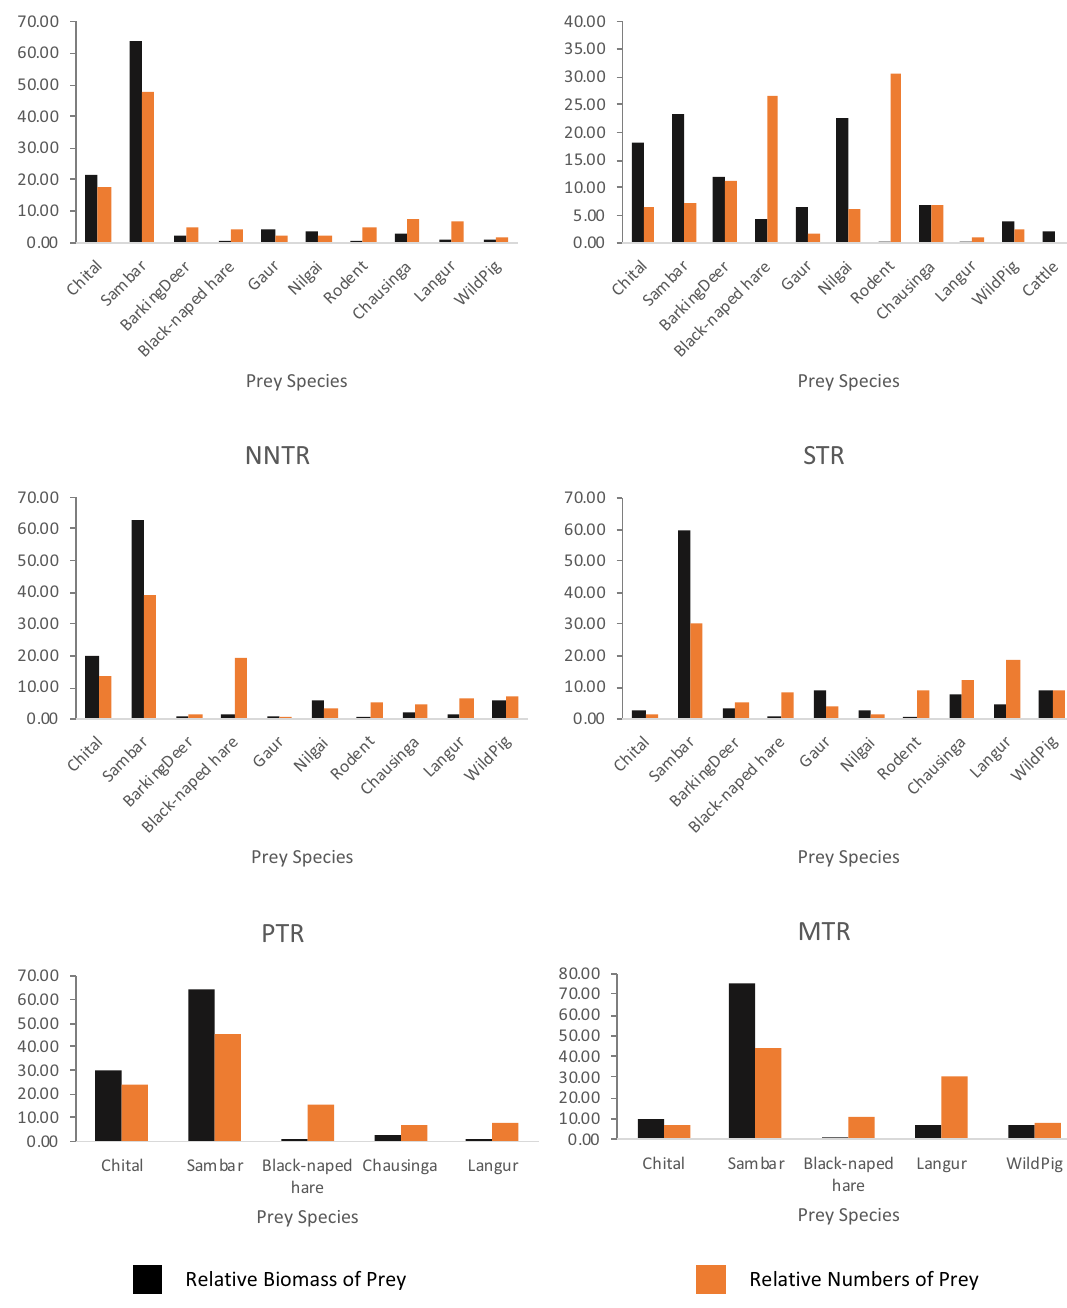
Figure 2. Relative biomass of prey species and relative numbers of prey harvested by dholes across the study sites, Maharashtra, India: TATR Tadoba Andhari Tiger Reserve, NNTR Nawegaon-Nagzira Tiger Reserve, STR Sahyadri Tiger Reserve, UKWLS Umred Karhandla Wildlife Sanctuary, MTR Melghat Tiger Reserve, PTR Pench Tiger